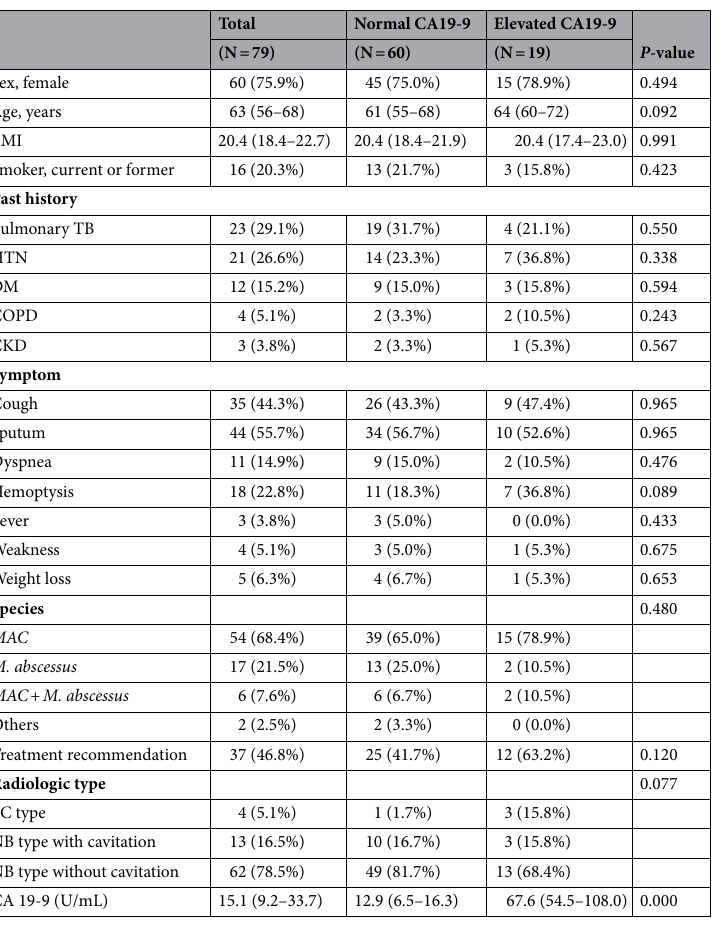
Table 1. Clinical characteristics of patients with pulmonary nontuberculous mycobacterial disease according to the serum CA19-9 level. Values are expressed as numbers (%) or medians (1Q–3Q). CA carbohydrate antigen, BMI body mass index, HTN hypertension, DM diabetes mellitus, COPD chronic obstructive pulmonary disease, CKD chronic kidney disease, MAC Mycobacterium avium complex , FC fibrocavitary, NB nodular